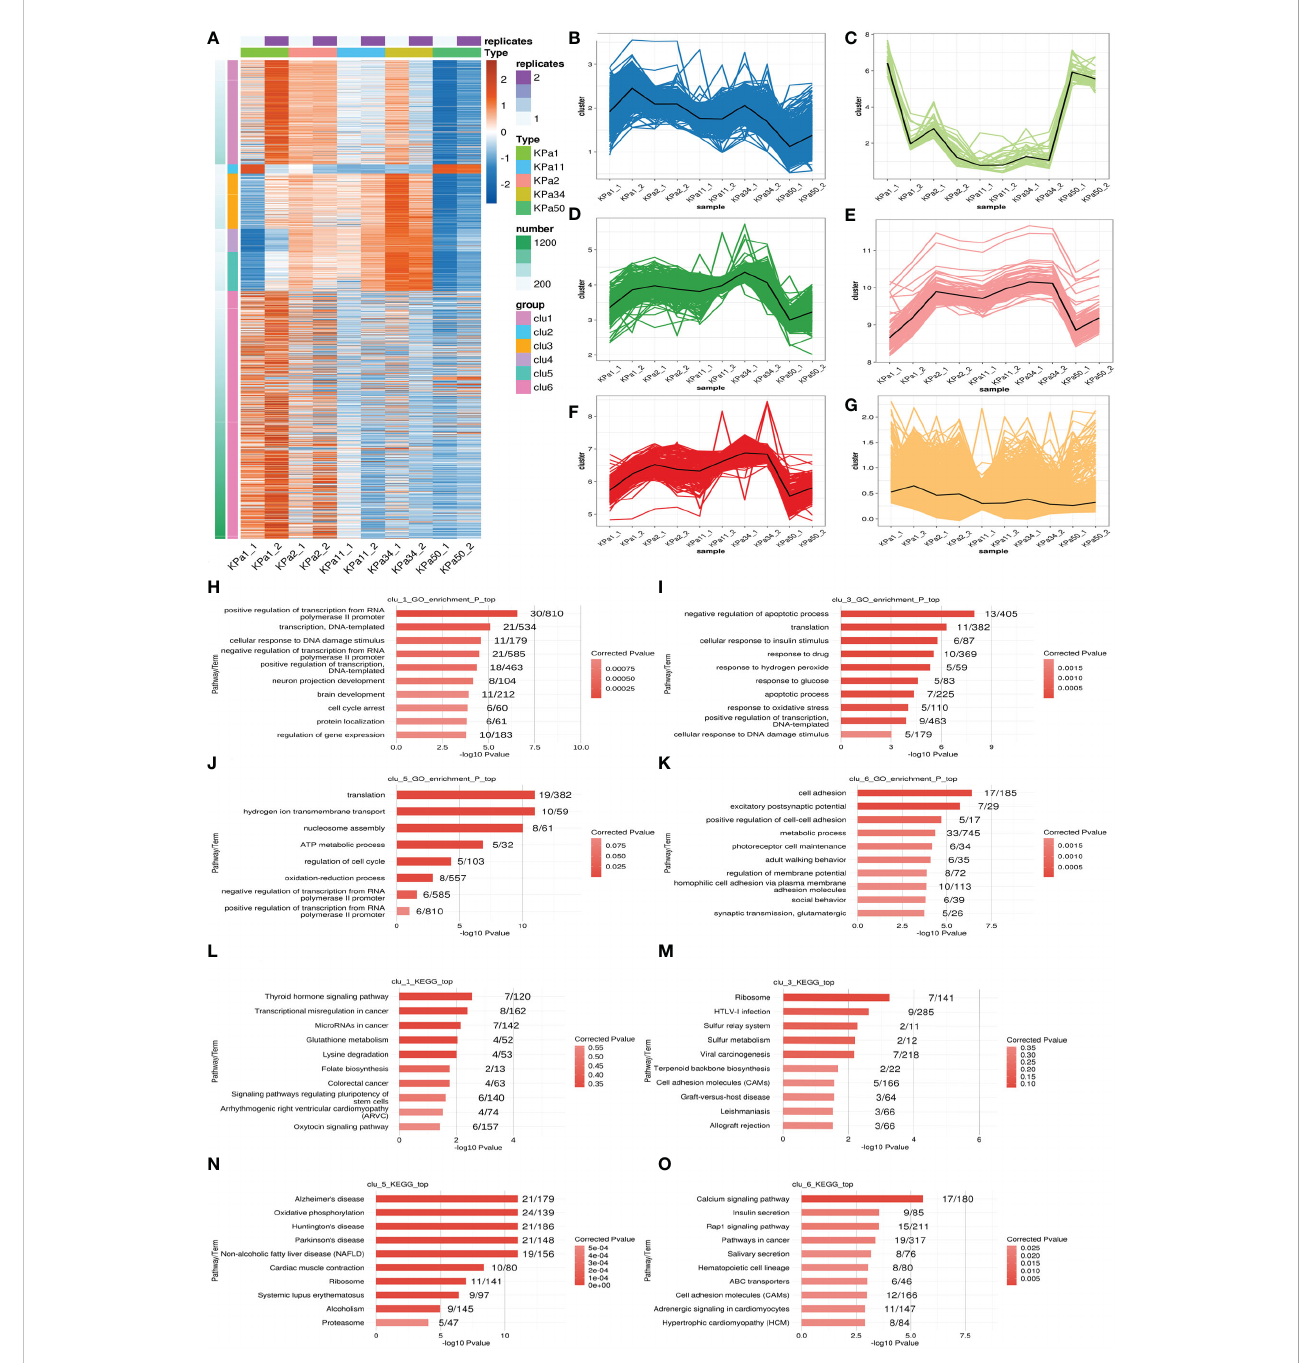
FIGURE 3 (A) k-means clustering of differentially expressed lncRNAs. (B – G) Genes are separated into 6 clusters, the black line represents the average expression value of all genes in each cluster. (H – K) Ten GO terms with signi fi cant differential expression identi fi ed from GO analysis of the biological processes represented in the different clusters. (L – O) The top ten KEGG pathways with signi fi cant expression differences in the identi fi ed